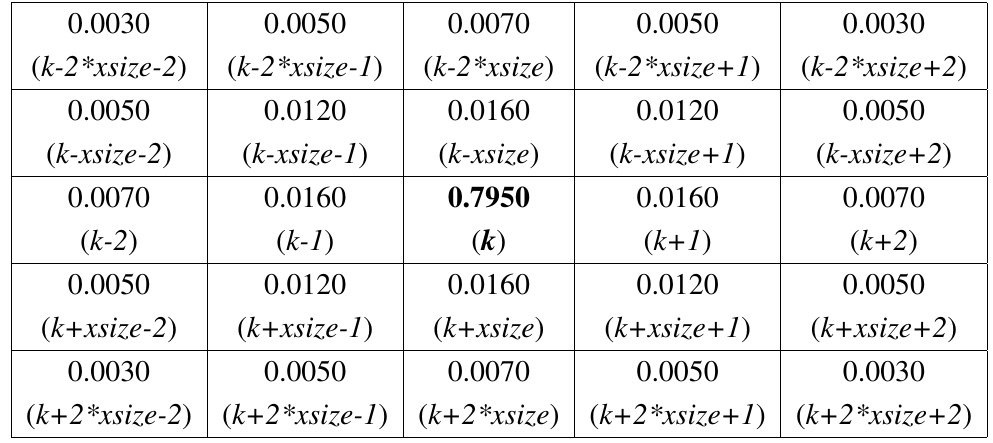
Table 3. PSF of the imaging system defined as a symmetrically space-invariant 5 × 5 matrix around the k -th pixel in the blurred image resulting from simulations of average soft breast- like tissue and typical hard calcification opacities for X-ray beam of 24